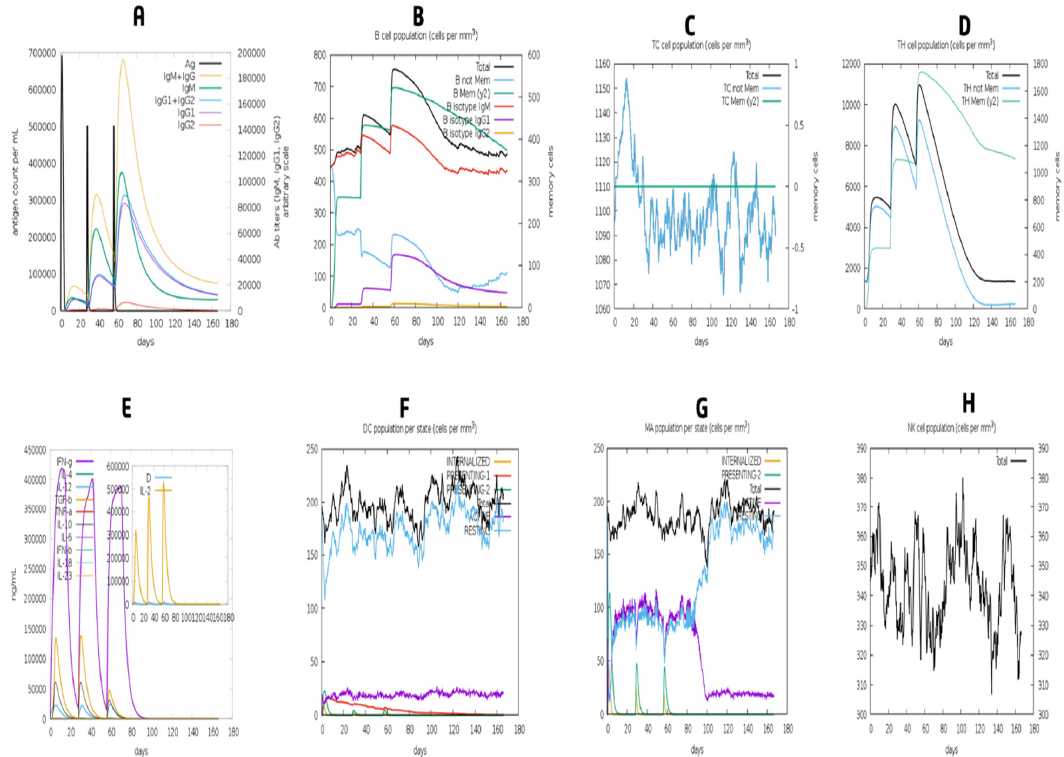
Figure 12. The vaccine has elicited an immune response. The graph shows ( A ) immune responses of vaccine, ( B ) B-cell population, ( C ) cytotoxic T-cell population, ( D ) helper T-cell population, ( E ) induction of cytokines and interleukins, ( F ) dendritic cell population per state, ( G ) macrophage population per state and ( H ) Natural Killer cells (total count).